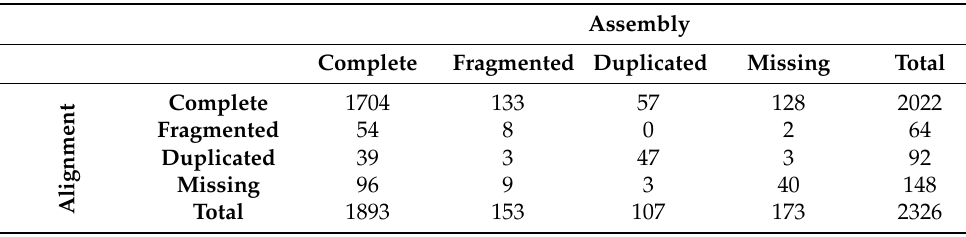
Table 2. Comparison of BUSCO analysis on de novo assembly and alignment against the L. japonica reference sequence. Counts represent the number of individual BUSCOs that met the respective criteria in the assembly and